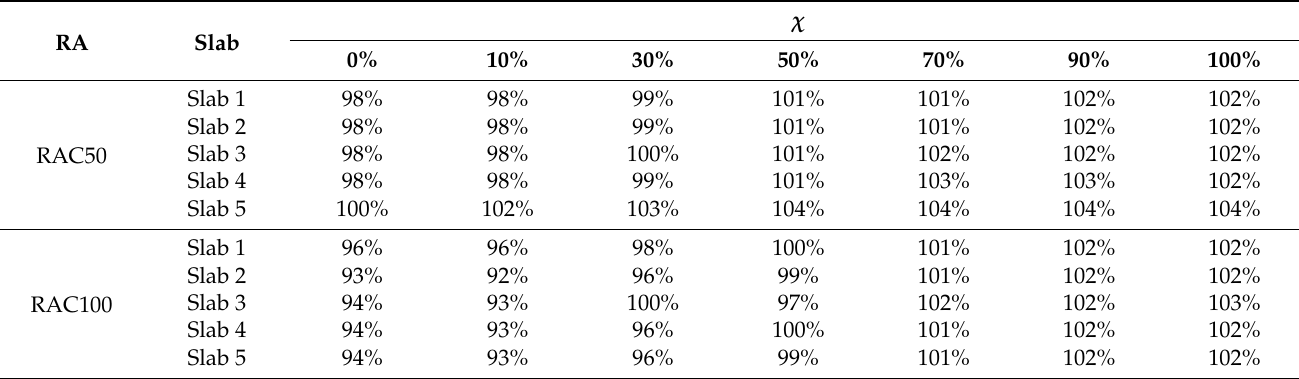
Table 8. Ratio β RAC/ β NAC of slabs. prEN1992 [32]. γ NAC = 1.40 and γ CRAC 50 = 1.50; γ RAC 100 = 1.60 (after calibration).